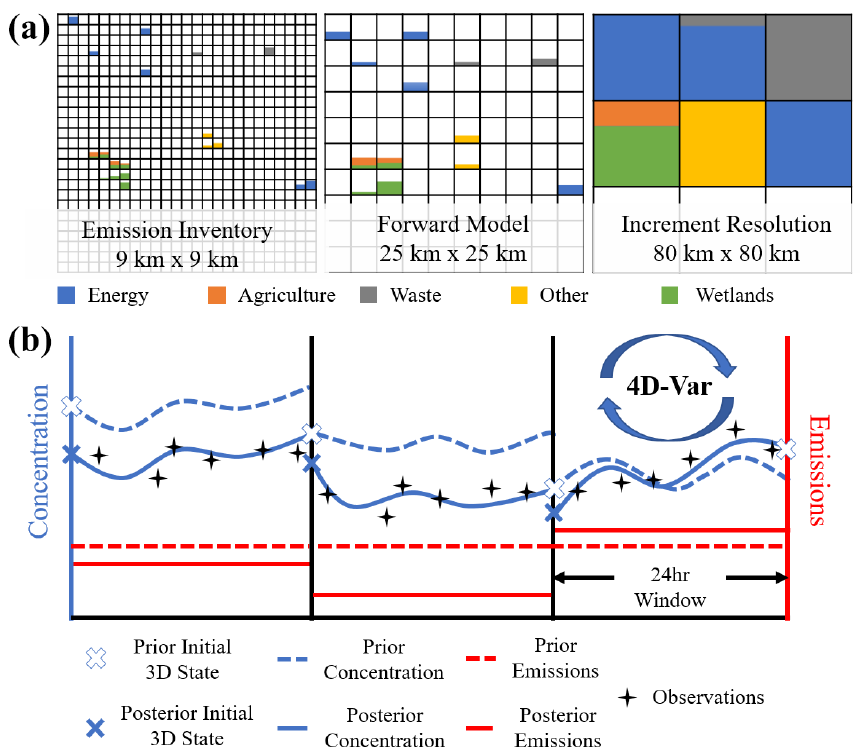
Figure 1. (a) Schematic of different resolutions used in the inversion shown by pseudo-data for five sectors. The magnitude of prior emissions at ∼ 9km (left panel) and those same emissions used as input to the forward model at ∼ 25km (middle panel). The inversion increment at ∼ 80km, resulting scaling factors are applied to all sectors within the grid cell, the boxes indicate relative contribution per sector (right panel). (b) Schematic of inversion setup using the 24-h window, correcting for the initial 3D state, emissions, and initial conditions in the prior of the subsequent